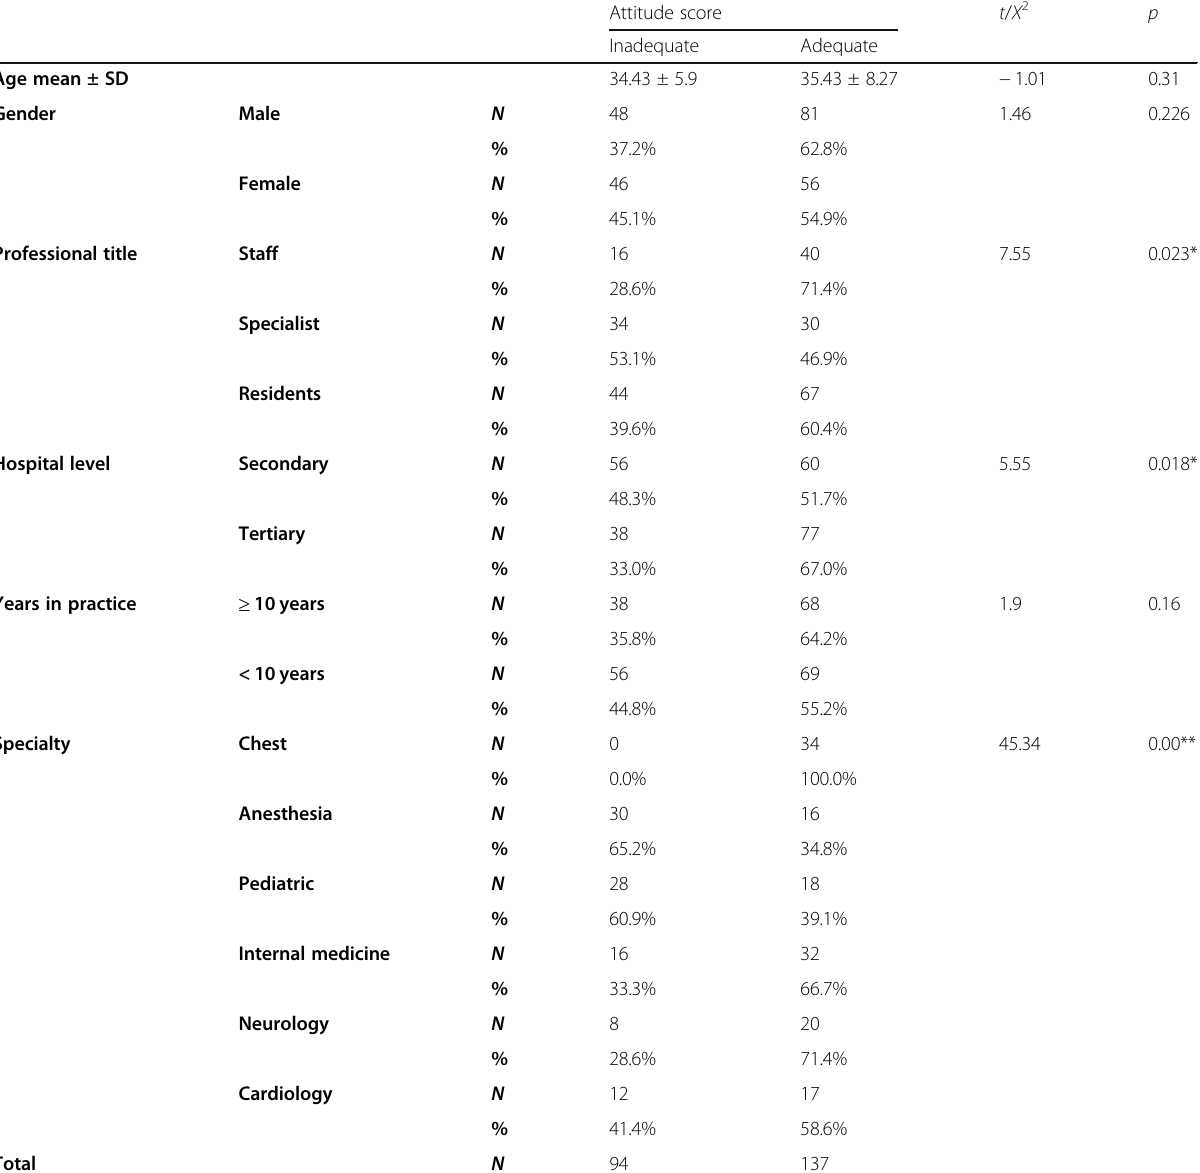
Table 8 OSA attitude score in relation to physicians ’